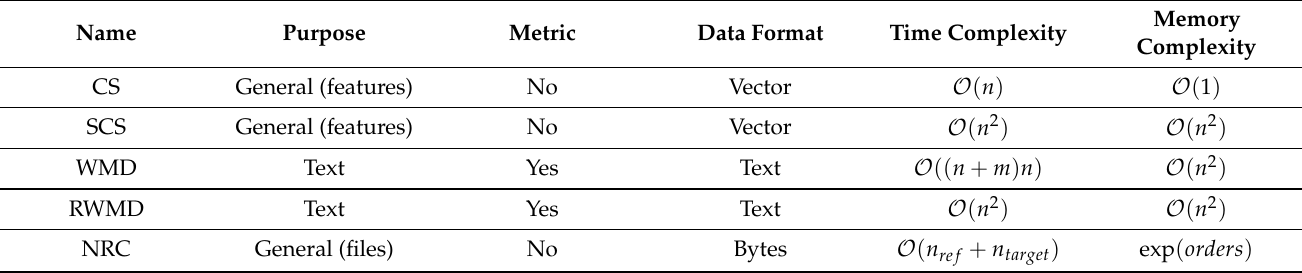
which limits the required memory and keeps it at an acceptable rate.